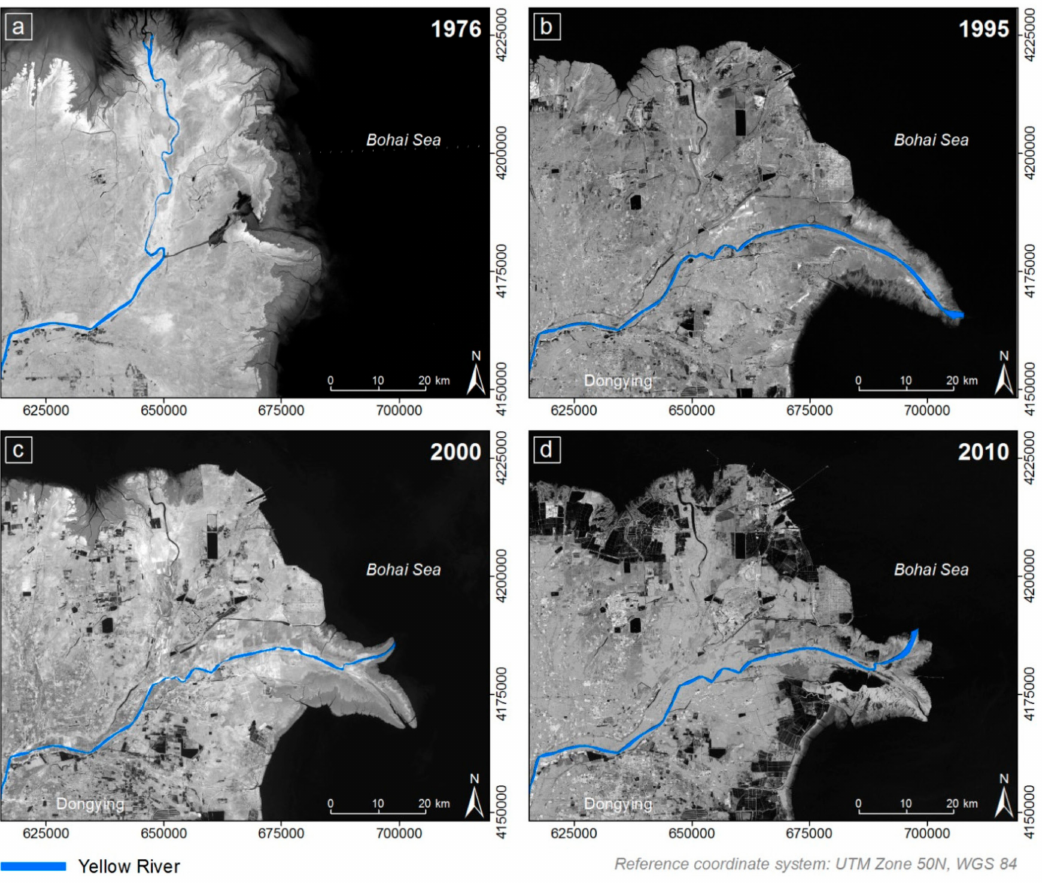
Figure 4. River course changes of the Yellow River in the Yellow River Delta from 1976 to 2010 as extracted from Landsat MSS and Landsat TM data for four time steps. To better illustrate the river course, RGB images are displayed in grey scale. From 1976 ( a ) to 1995 ( b ) the river was substantially re-directed from its northern outlet to the East. Redirections in the late 1990’s ( c , d ) occurred due to management decisions of Shengli Oilfield, as explained in the